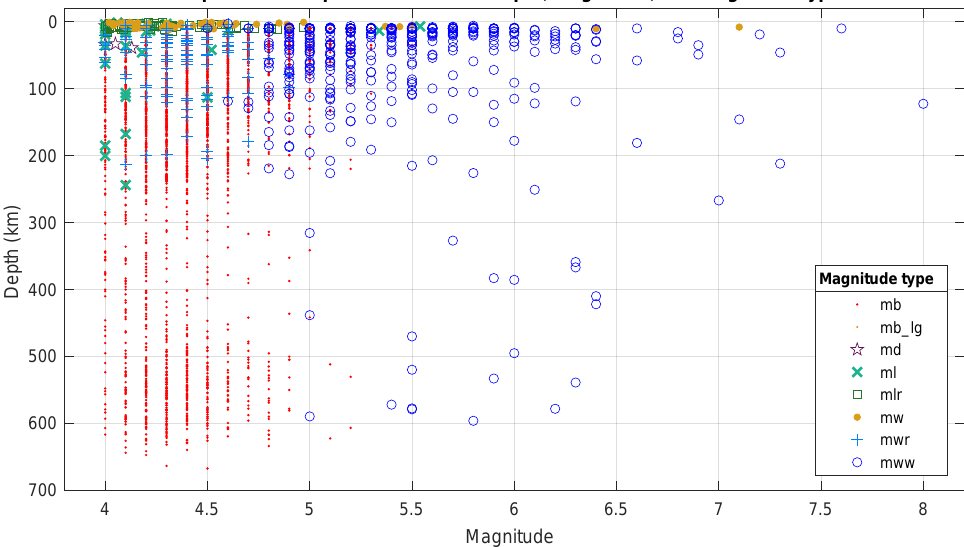
Figure 3. Distribution of earthquakes according their depth (km) and magnitude, indicating their magnitude type with different symbols and colors.